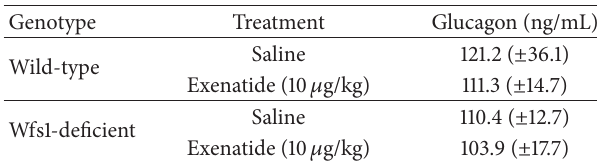
Table 1: Effect of treatment with exenatide on glucagon